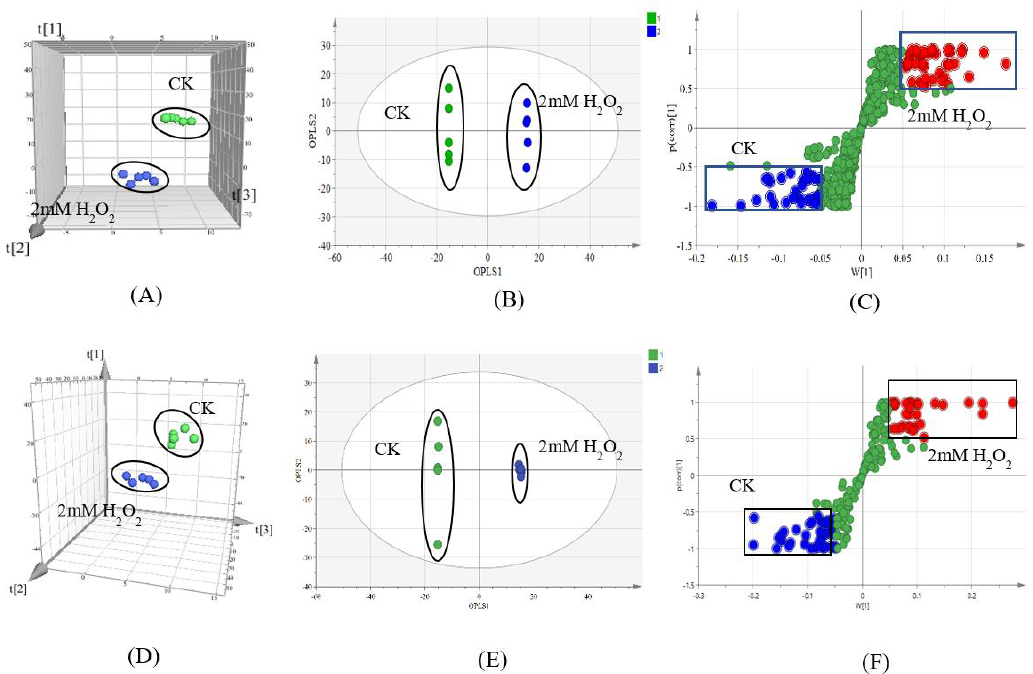
Figure 2. ( A ) PCA score plots according to HPLC − MS in positive ionization mode (PC 1 = 47.6%, PC 2 = 17.1%, and PC 3 = 13.0%). ( B ) OPLS − DA score plots in positive ionization mode (R 2 x = 0.601, R 2 y = 1, Q 2 = 0.957). ( C ) S-plot based on OPLS − DA model in positive ionization mode. ( D ) PCA score plots based on HPLC – MS in negative ionization mode (PC 1 = 37.3%, PC 2 = 14.5%, and PC 3 = 10.6%). ( E ) OPLS − DA score plots in negative ionization mode (R 2 x = 0.726, R 2 y = 1, Q 2 = 0.928). ( F ) S − plot based on OPLS − DA model in negative ionization mode. CK, control, without H 2 O 2.